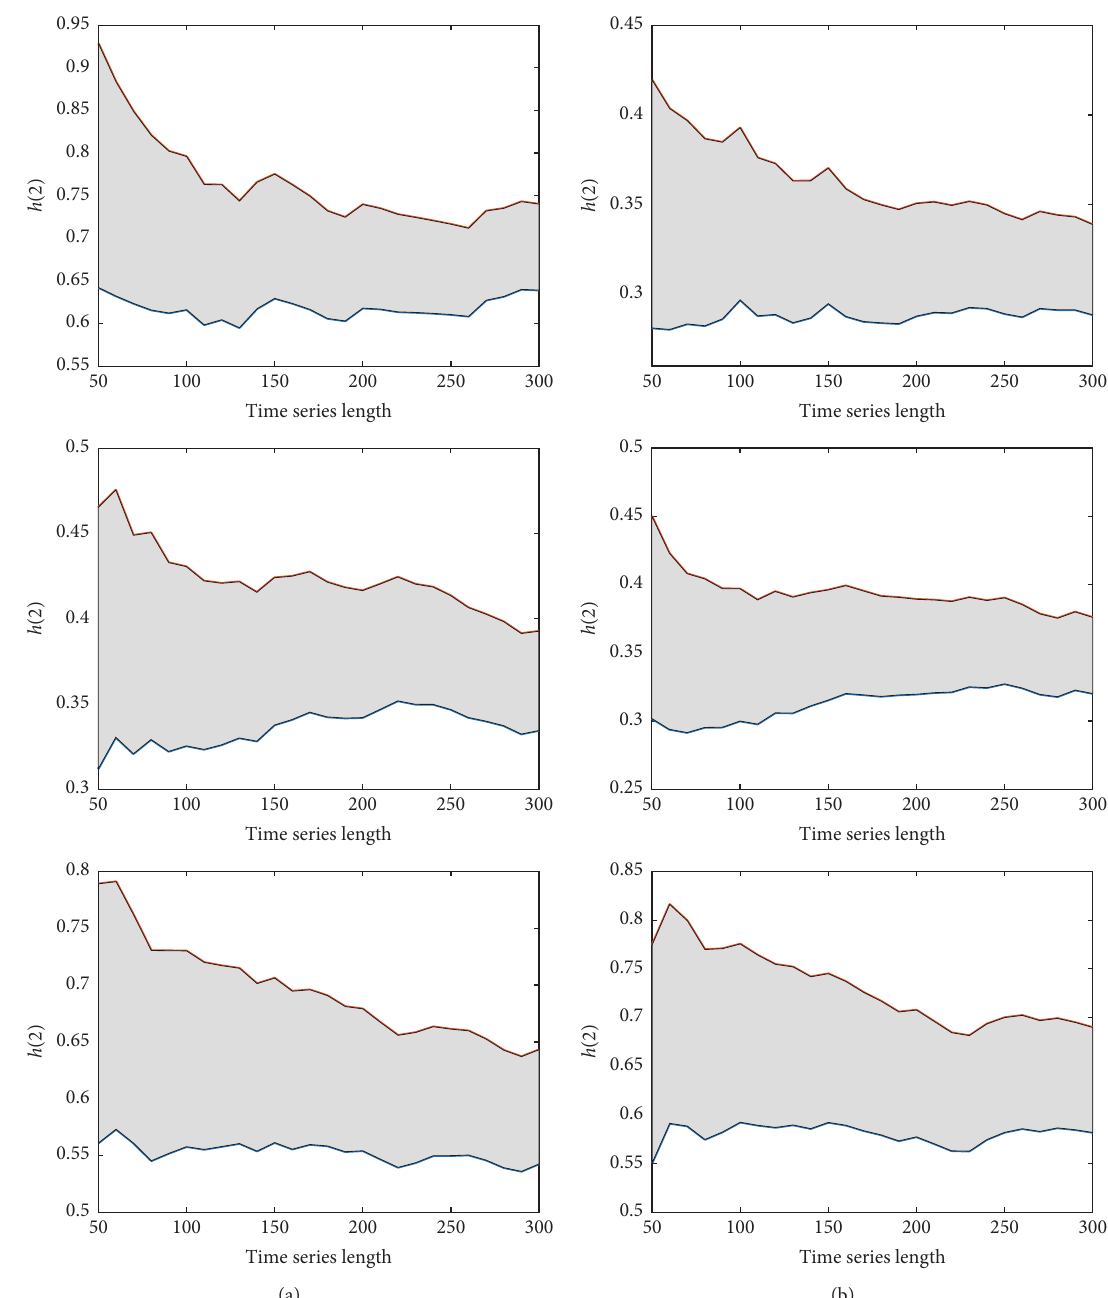
Figure 7: Confidence intervals of h ( 2 ) versus the length of PM confidence level by 95 . 0 %. From top to bottom are Seoul, Busan, and